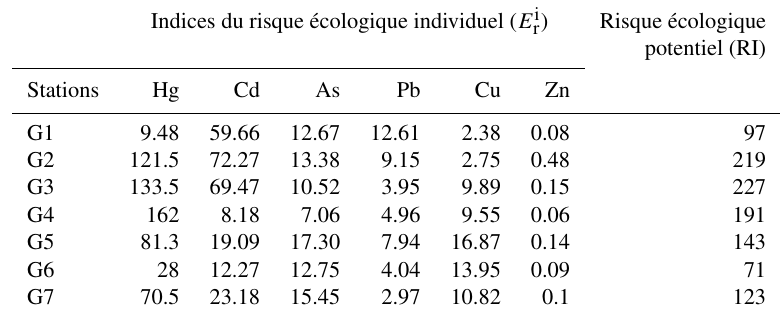
Tableau 5. Récapitulatif des Indices du risque écologique individuel ( E i r ) et du risque écologique potentiel (RI).